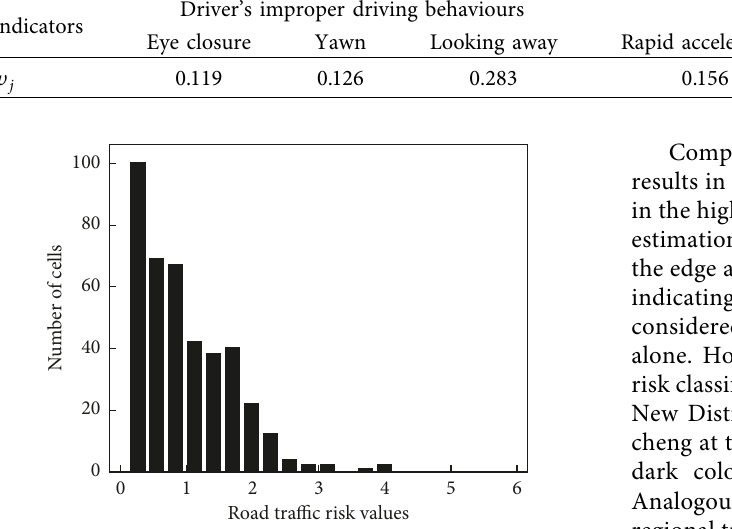
Figure 4: Road traffic risk value distribution.